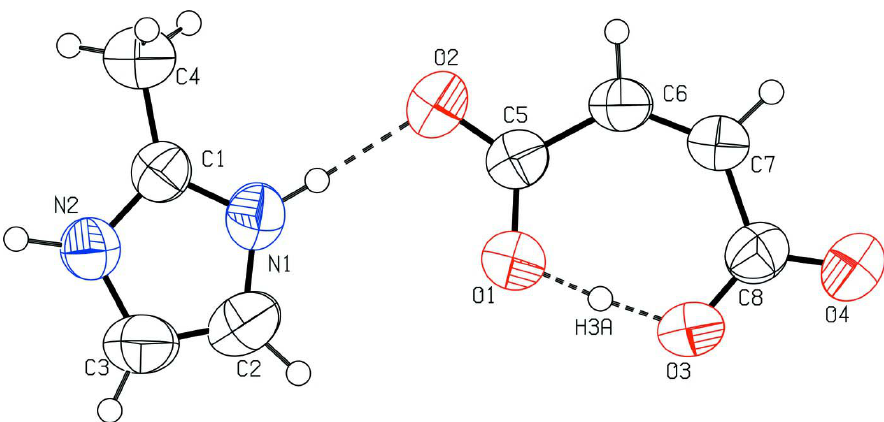
Figure 1 Molecular structure of (I), showing the atom-numbering scheme. Displacement ellipsoids are drawn at the 50% probability level. H-bonds are shown in dashed lines.